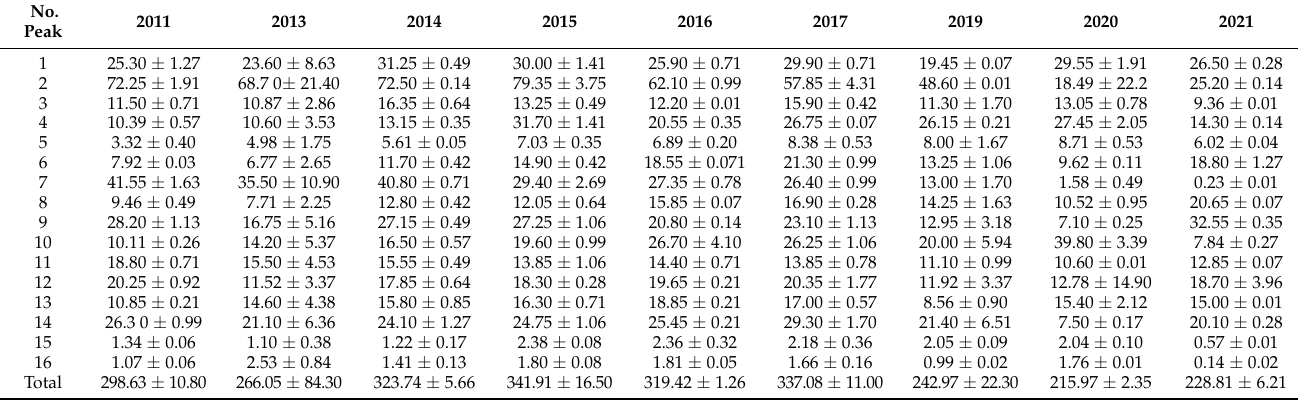
Table 4. Semi-quantitative results of the chromatographic analysis of Grillo wines, expressed